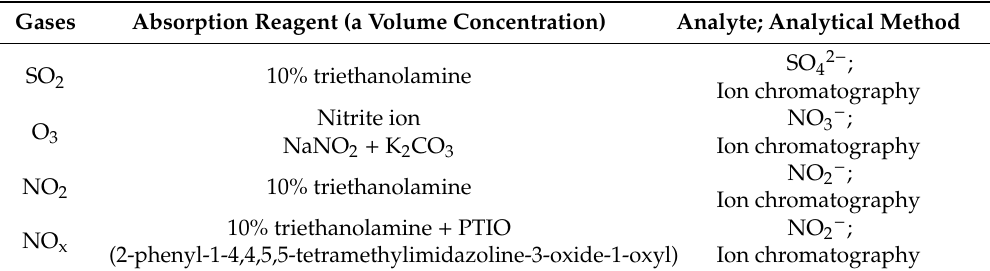
Table 1. Reagent, analyte and analytical method.